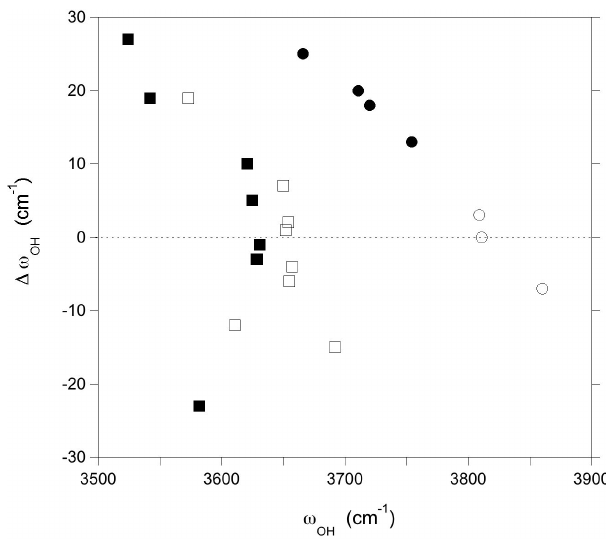
Figure 2. Relation between theoretical OH stretching frequency ( ω OH ) and OH bond length ( d (OH)) in dravite models (1 × 1 × 2 supercell and hexagonal cell; Table 1).